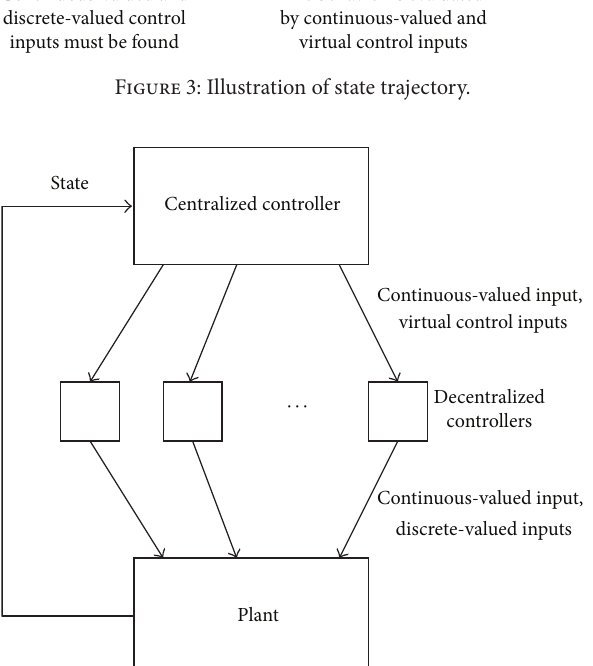
Figure 4: Control system considered in this